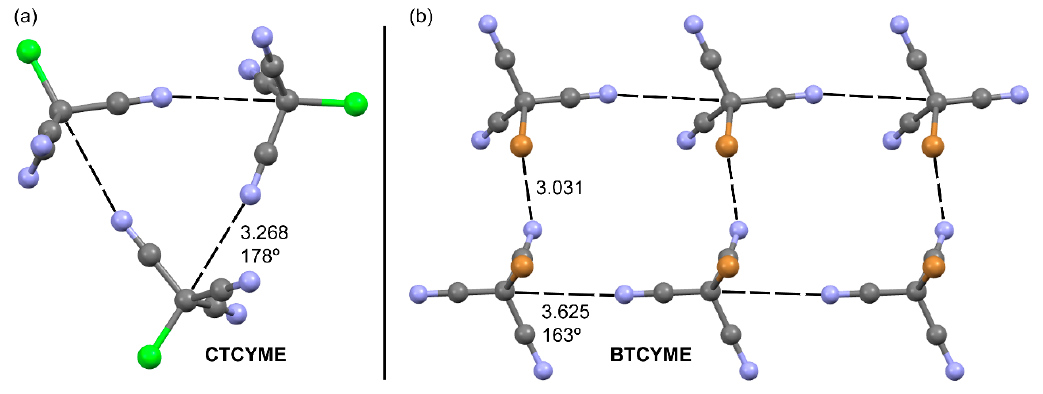
Figure 5. X-ray structures of CSD refcodes. ( a ) CTCYME; ( b ) BTCYME. Distances in Å are given adjacent to the dashed lines used to represent the TtBs.